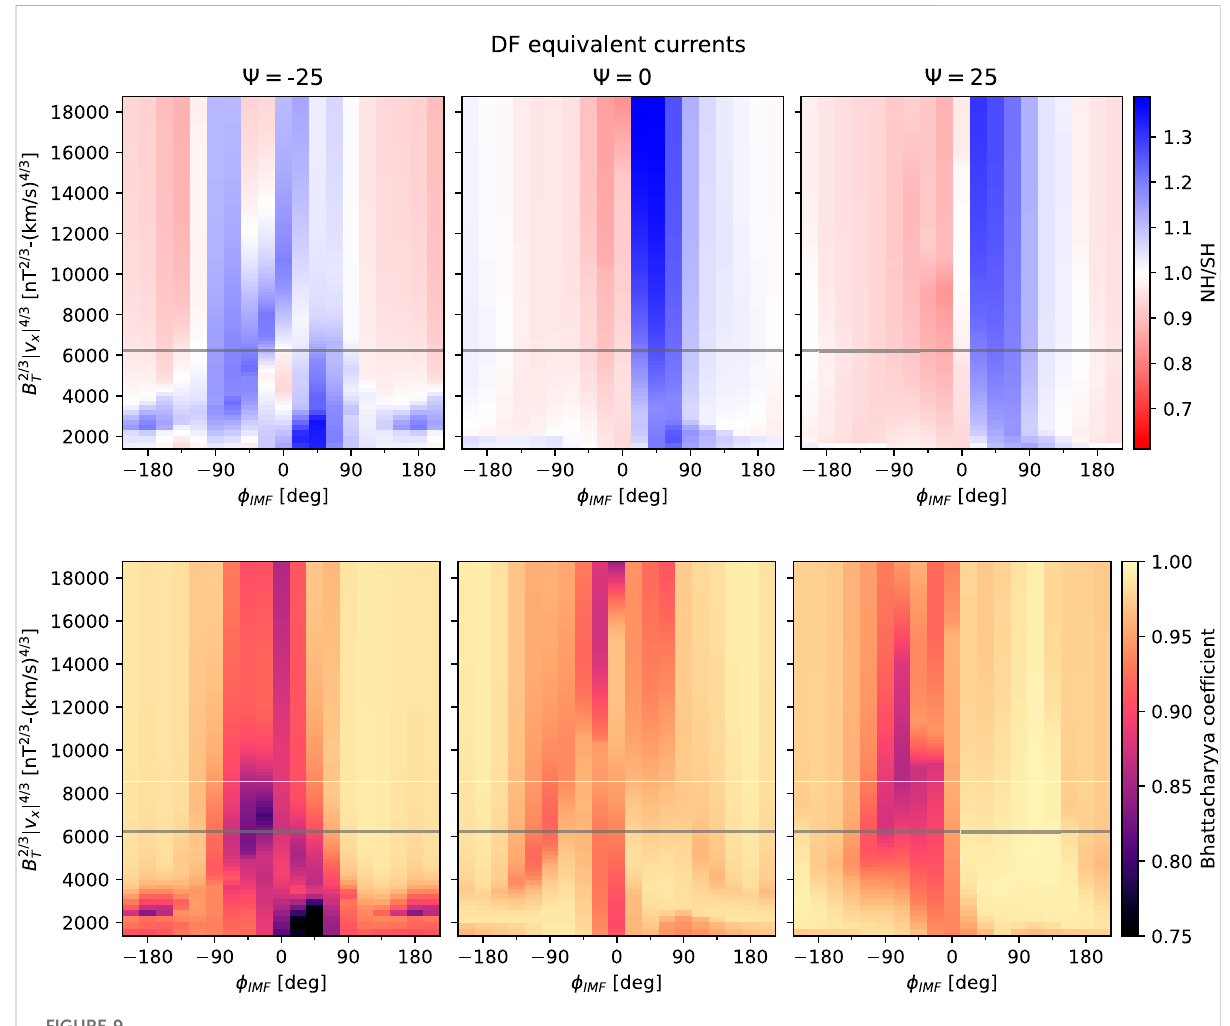
FIGURE 9 Northern and southern total divergence-free current ratio (top row) and Bhattacharyya coef fi cient of divergence-free current distributions (bottom row) in the same layout as Figure